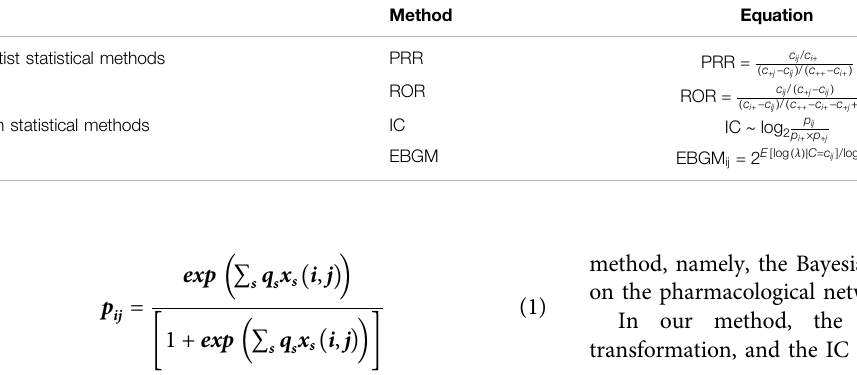
Method Equation